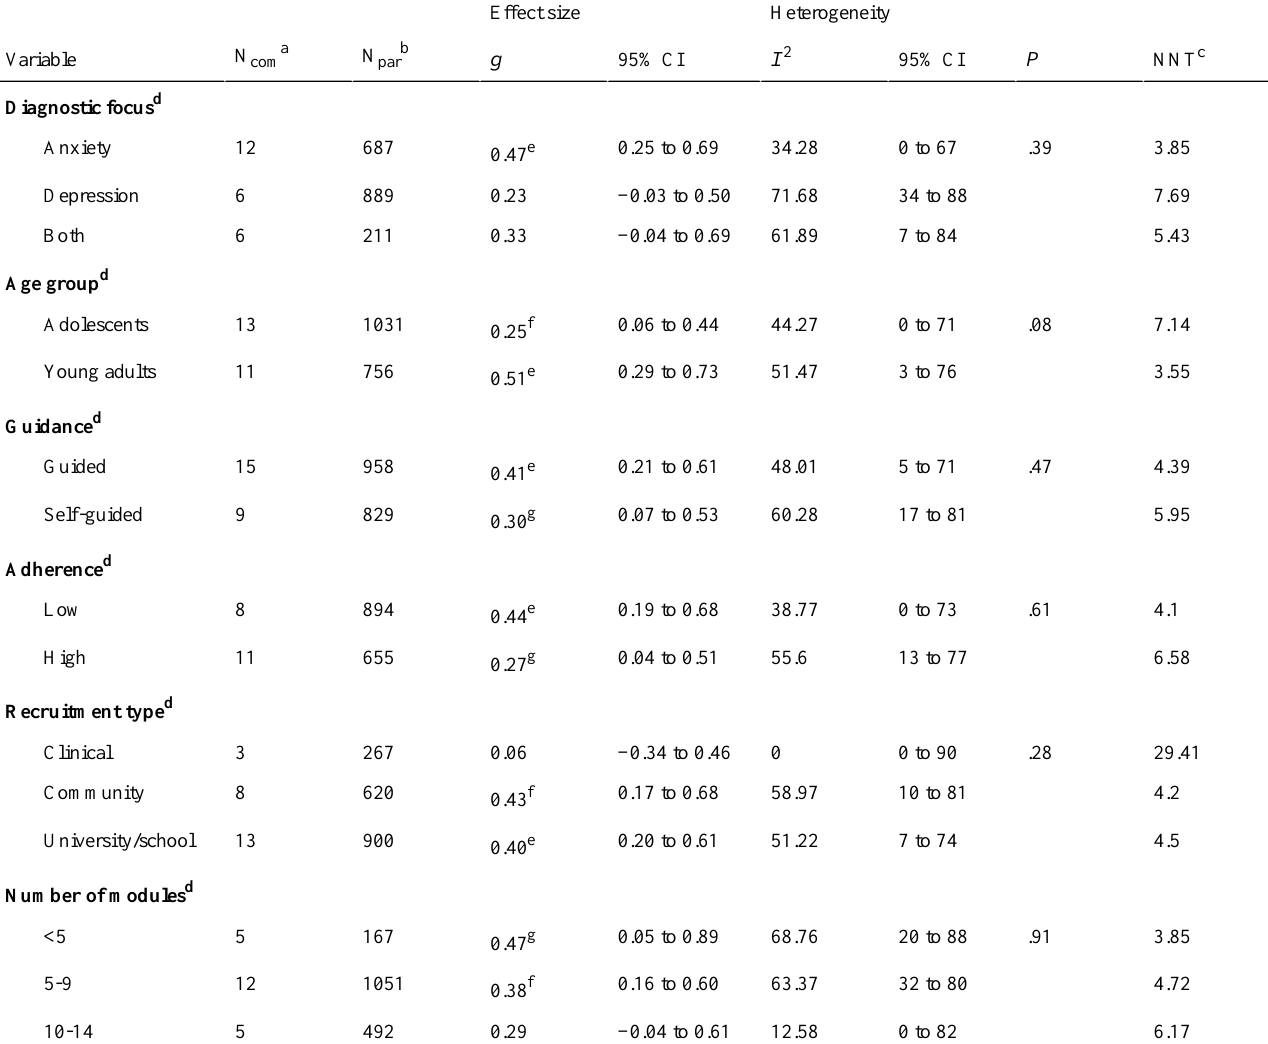
Table 5. Effect sizes regarding anxiety symptoms in the subgroup analyses of studies comparing computerized cognitive behavior therapy in adolescents and young adults with active treatment and passive controls at